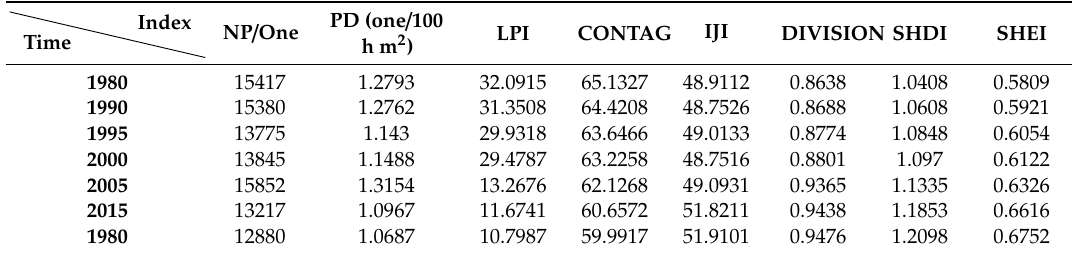
Table 7. Landscape pattern indexes on the landscape